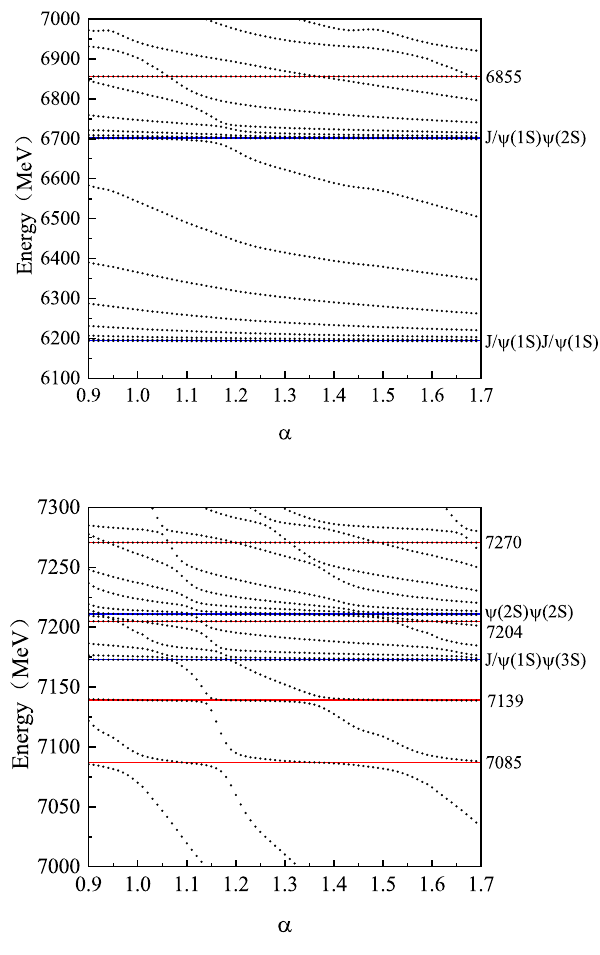
Figure 13. The stabilization plots for the energies of the states for J PC = 2 ++ obtained by considering the full-channel couplings with respect to the scaling factor α . Upper for energies 6100–7000 MeV and down for energies 7000–7300